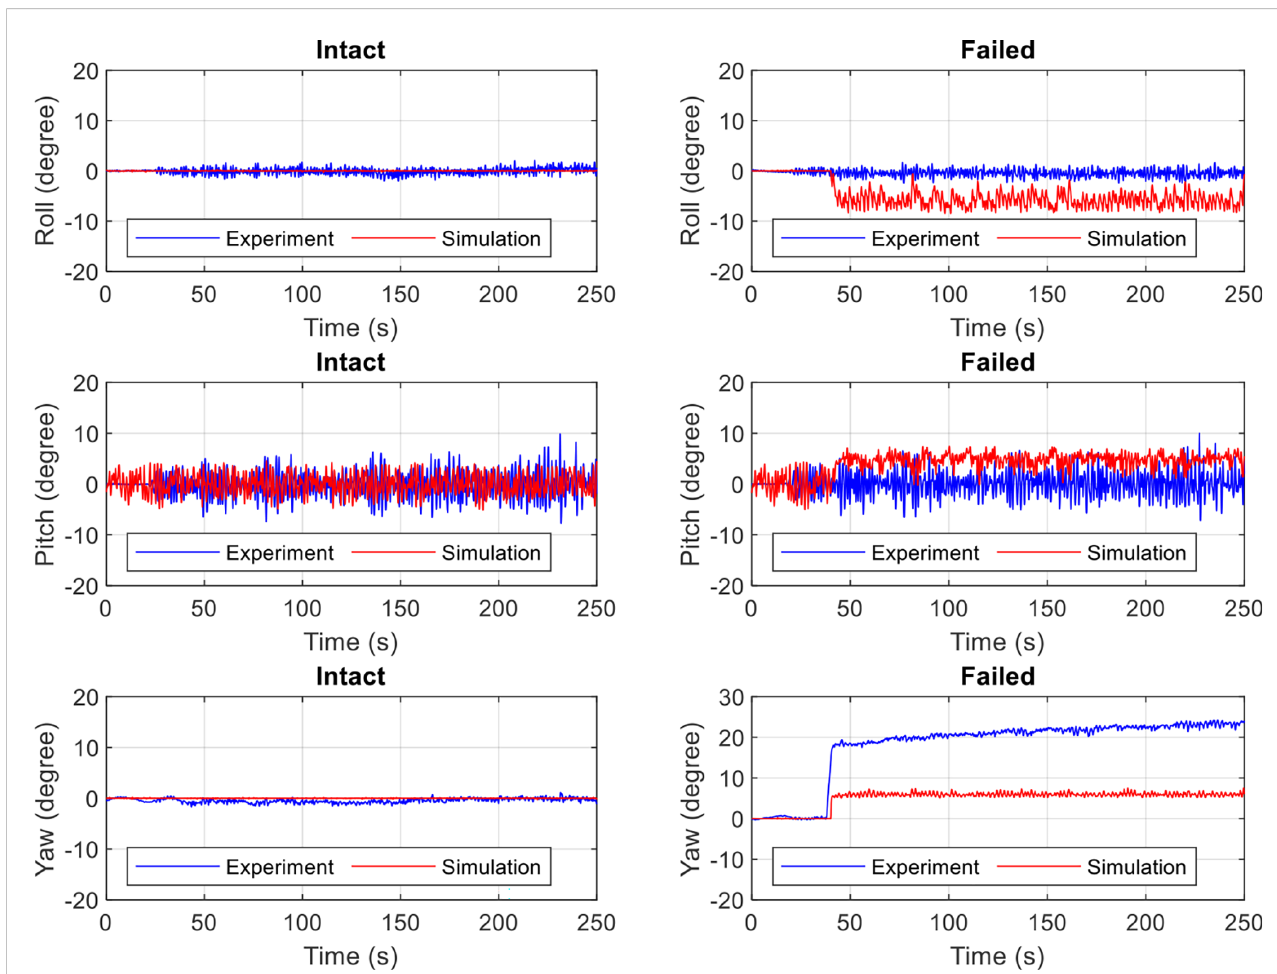
FIGURE 8 Time series of the roll, pitch, and yaw rotations of the fl oating collar in the experiment and simulation under the intact and failed